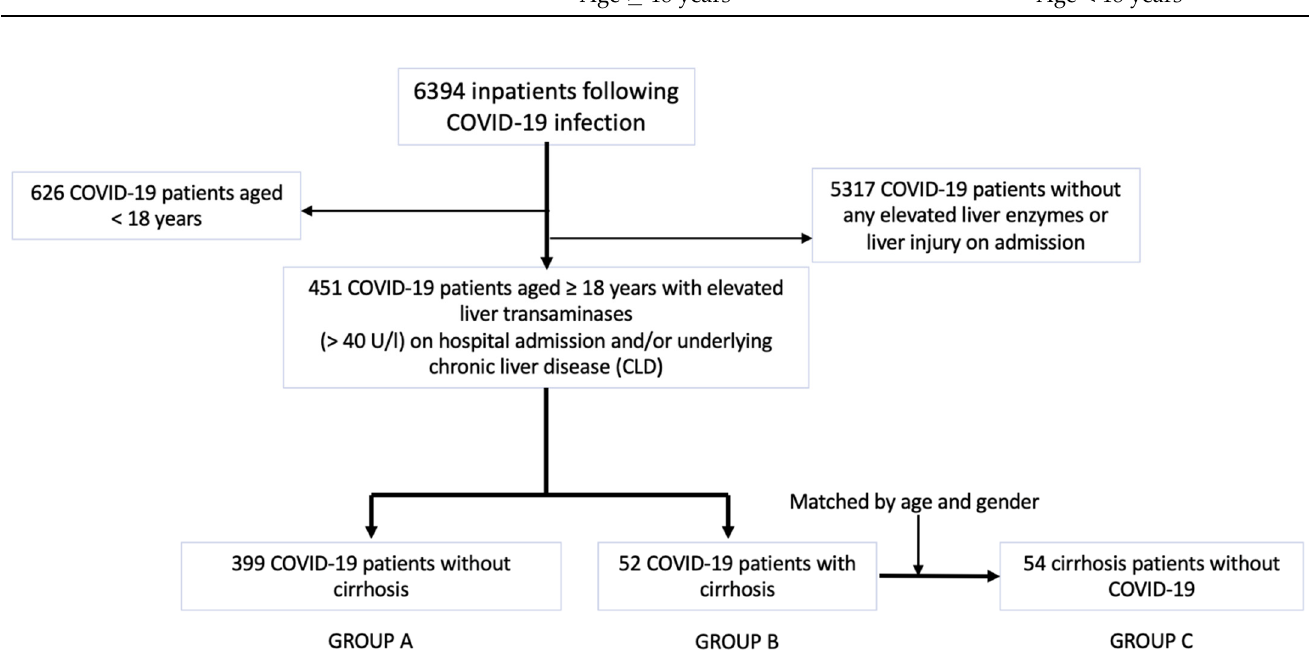
Figure 1. The flowchart of patient enrolment and cohort selection . Table 1. Inclusion and exclusion criteria.